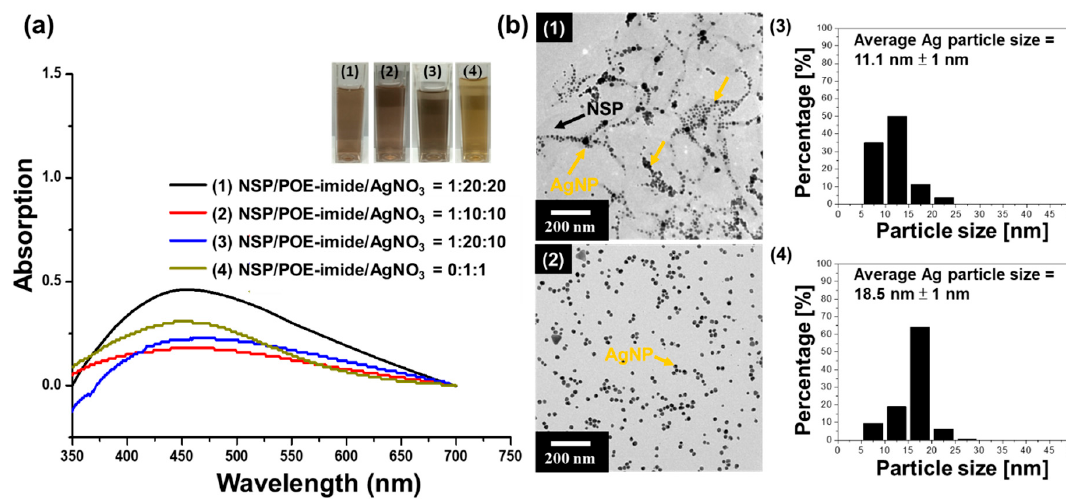
Figure 2. ( a ) UV–Vis absorption spectra of AgNPs suspension with various weight fractions of POE- imide and NSP. Inset: NSP/POE-imide/AgNO 3 reductions with weight ratios of (1) 1:20:20, (2) 1:10:10,